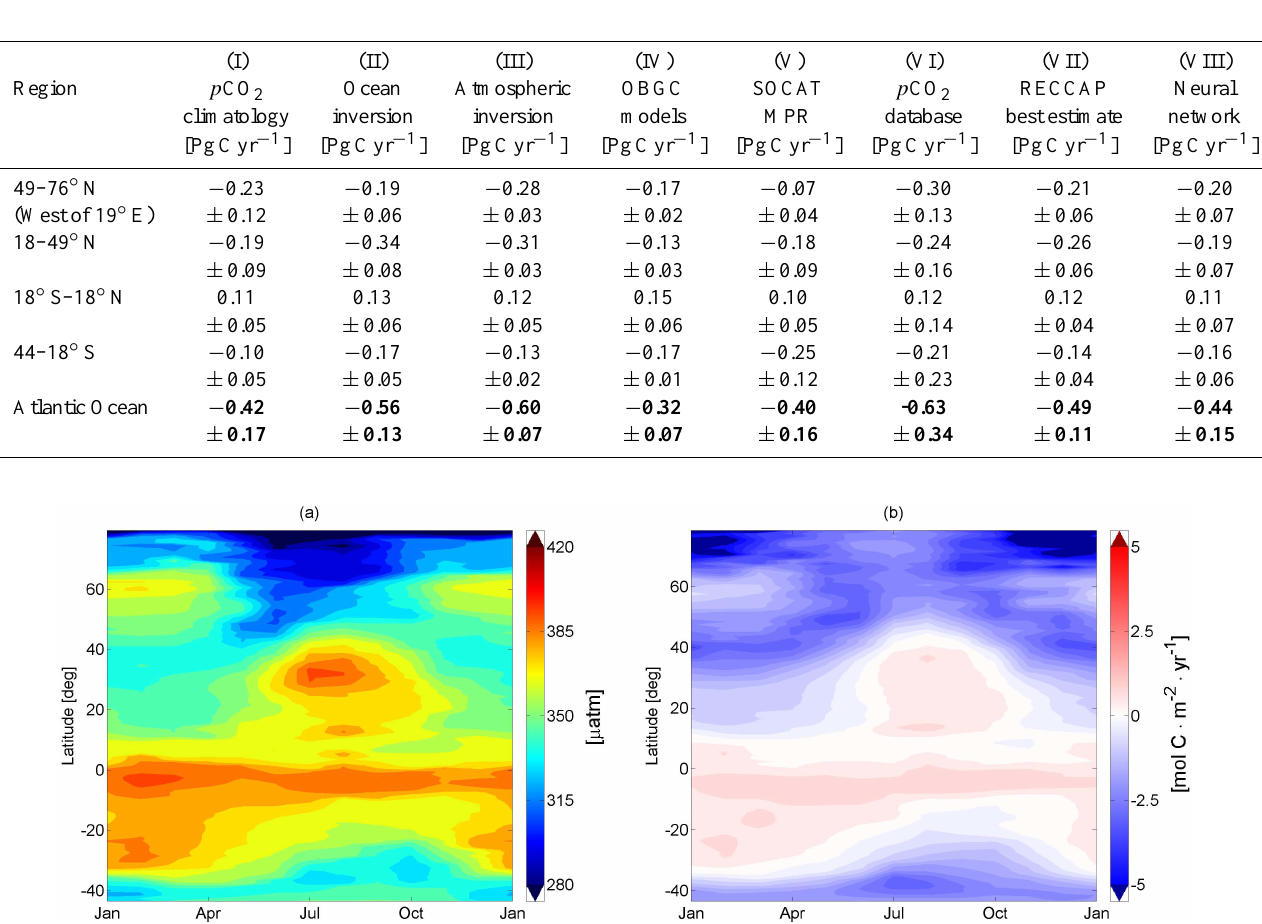
Table 3. Comparison of regional and basin-wide decadal mean CO 2 fluxes in PgCyr − 1 from the neural network-based method (column VIII) compared to a range of other methods. This includes (I) the p CO 2 climatology of Takahashi et al. (2009) and the tier 1 methodologies described in Schuster et al. (2013) which include (II) ocean inversion (Gruber et al., 2009), (III) atmospheric inversion (Peylin et al., 2013), (IV) ocean biogeochemical models as well as observation based results including (V) a SOCAT v1.5 based multi-parameter regression (Schuster et al., 2013) and (VI) an estimate based on the p CO 2 database of Takahashi et al. (2009) updated by McKinley et al. (2011). (VII) lists the best estimate from combining the different RECCAP methodologies as described in Schuster et al. (2013)